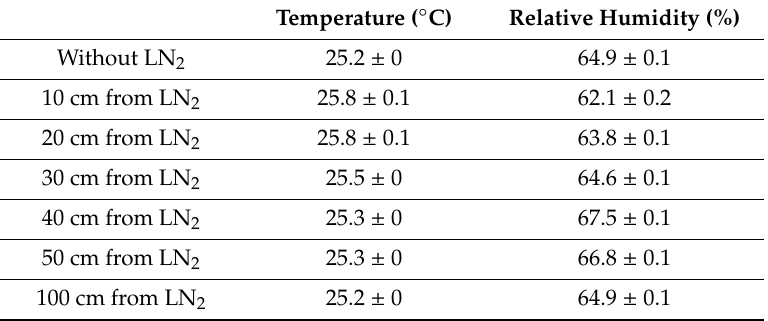
Table 1. Temperature and relative humidity values in the vicinity of liquid nitrogen (LN 2 ).